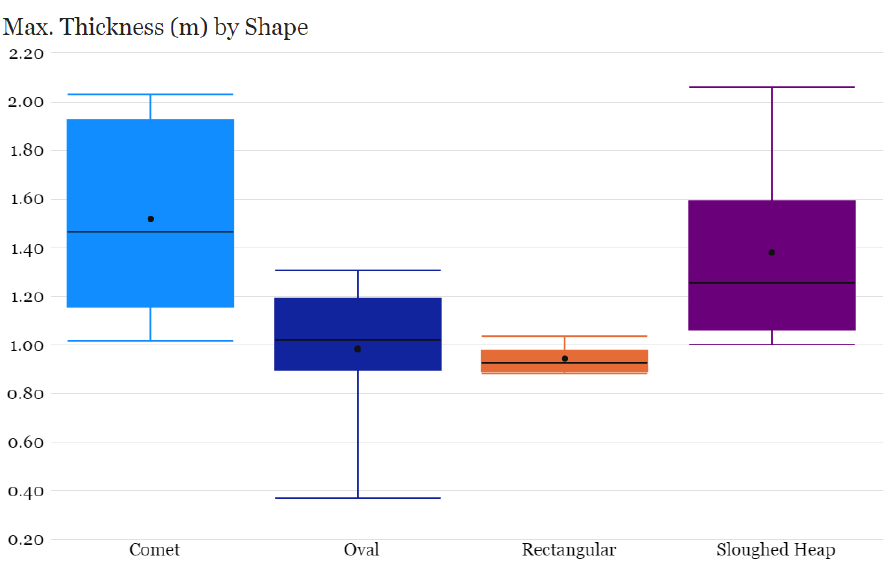
Figure 6. Box Charts of Max. Width (m) by Dump Profile Shape.